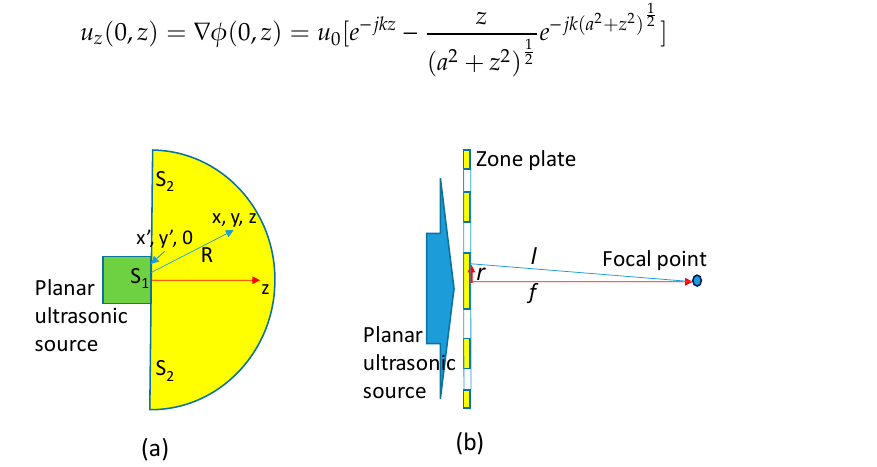
Figure 2. ( a ) Planar cylinder transducer enclosed in a baffle. ( b ) Diagram for locating the zone boundaries.